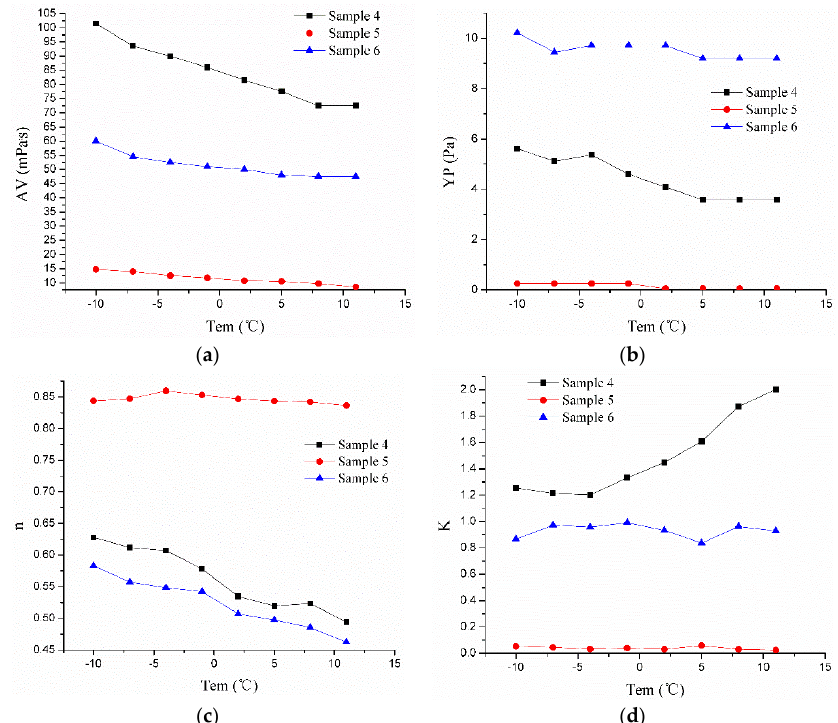
Figure 4. Rheological properties with temperature response curves of SFPDF containing the GC treatment agent. ( a ) AV with the temperature response curve; ( b ) YP with the temperature response curve; ( c ) n with the temperature response curve; and ( d ) K with the temperature response curve.